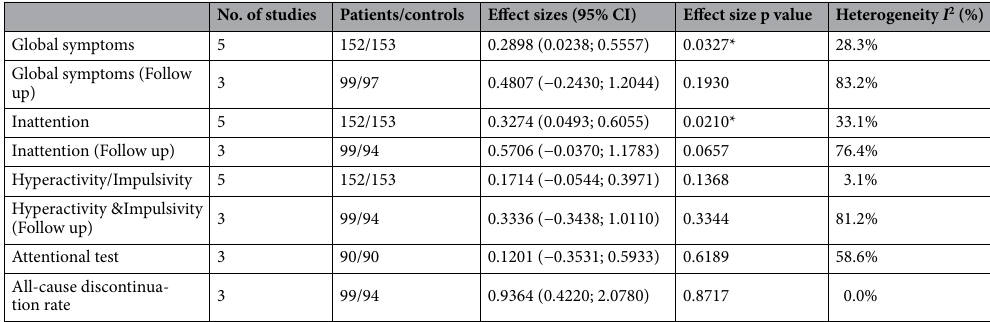
Table 2. The comparison of improvements in symptoms of ADHD between EEG-NF + Medications vs Medication alone from parents’ observation.